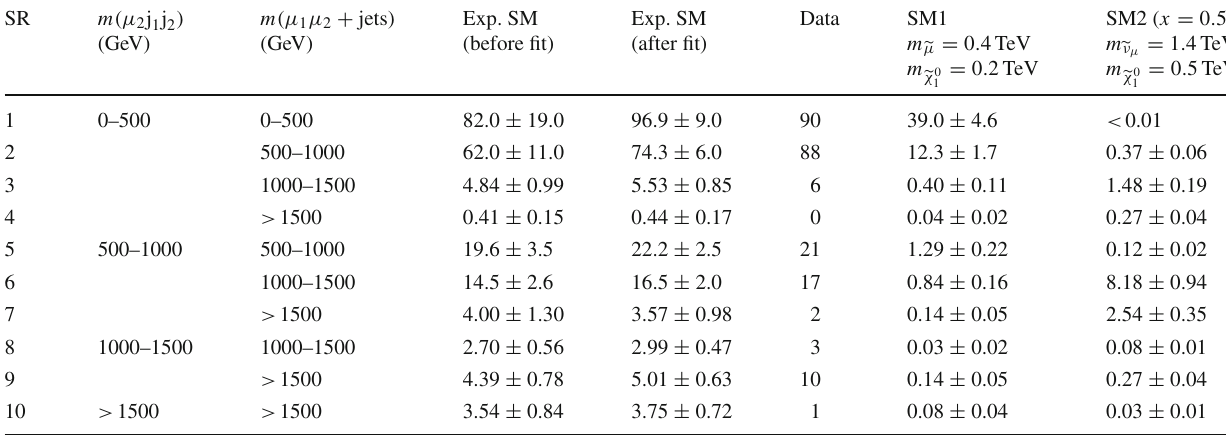
Table 2 Expected and observed event yields in the signal regions. The uncertainties are the total systematic uncertainties in the expected yields. Also shown are the expected yields for two signal points normalized to the expected limits on the cross sections SR m (μ 2 j 1 j 2